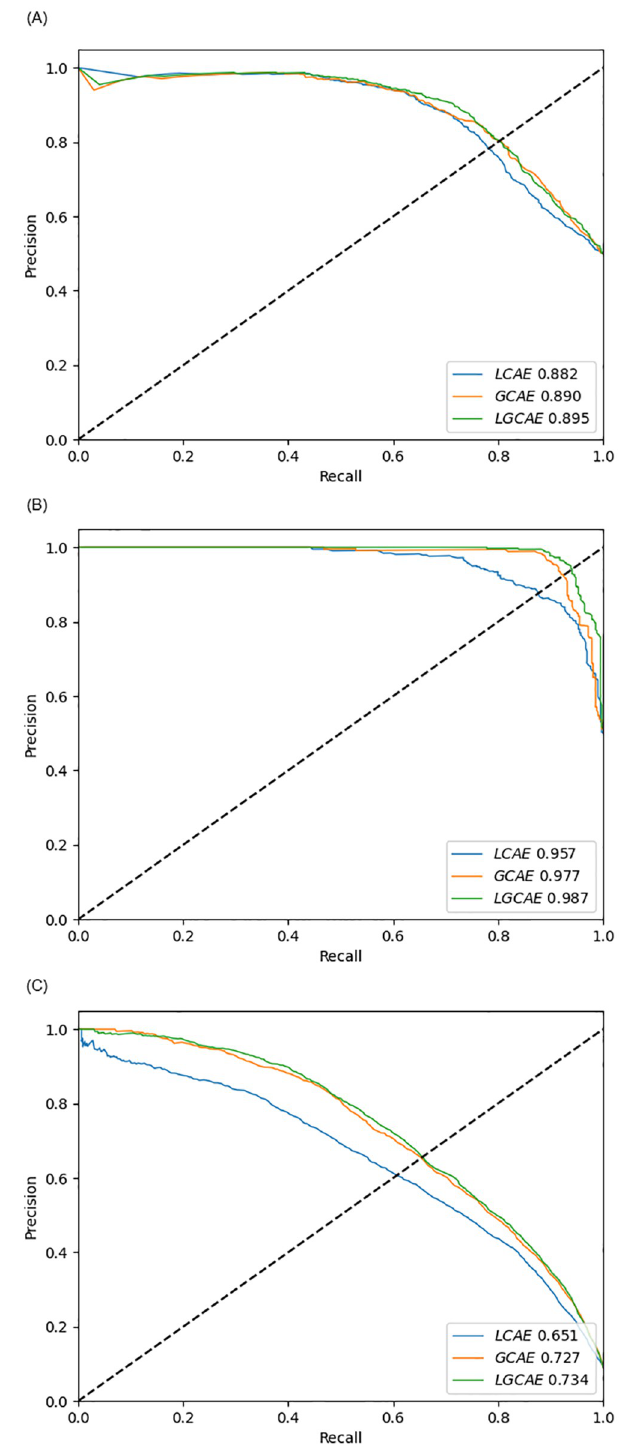
Fig 8. AU-PRC performance figures produced by proposed LGCA-VHPPI on 3 benchmark viral-host PPIs datasets. (a) Barman et al dataset. (b) DeNovo et al dataset. (c) Yang et al dataset.